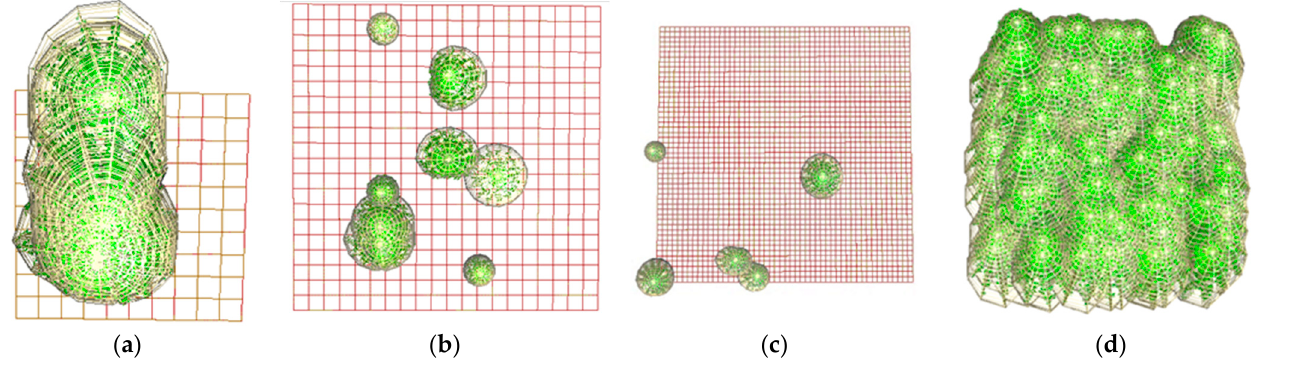
Figure 4. Profile diagram of mangrove cover in ( a ) mangrove-fish pond with high mangrove cover ( b ) mangrove-fish pond with medium mangrove cover ( c ) mangrove-fish pond with low mangrove cover and ( d ) intact mangroves. cover and ( d ) intact